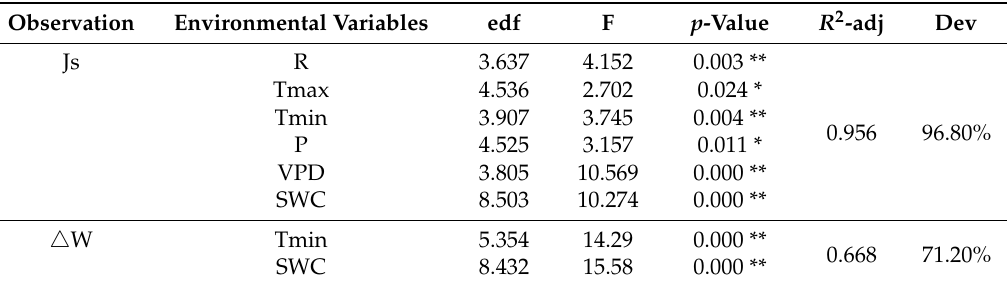
Table 4. GAM model results for the relationships between Js and (cid:52) W, and combined environmental